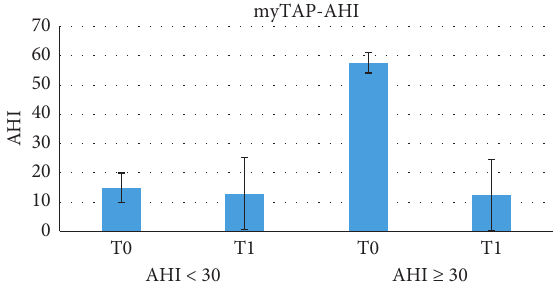
Figure 4: ANOVA and post hoc Tukey test showed a statistically significant difference in AHI at T0 versus T1 in the subpopulation AHI ≥ 30 ( p < 0 . 05) using the myTAP ™ device.